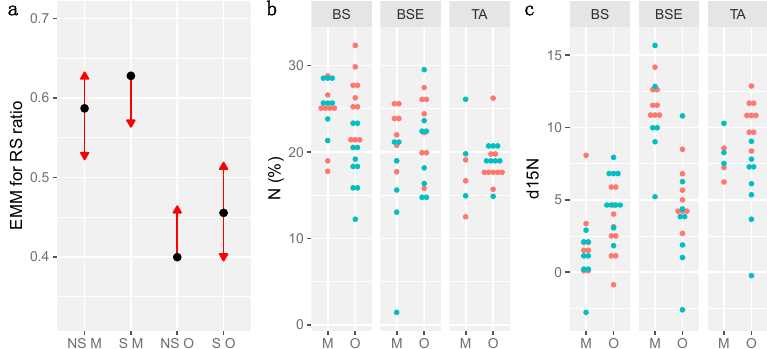
Figure 5. Comparison of estimated marginal means (EMM) showing significant differences of Root/shoot ratio between soil layers and sterilization treatments ( a ), and distribution of percent of N ( b ) and δ 15 N ( c ). BS: Black spruce stand, BSE: BS with Ericaceae, TA: Trembling Aspen stand, NS: non sterile, S: sterile, M: Mineral, O: Organic. In ( a ), blue bars indicate confidence intervals of estimated marginal means, arrows refer to comparisons among marginal means. If two arrows overlap, Tukey post-hoc tests are non-significant and p -value for pairwise comparisons are > 0.05. In ( b ) and ( c ), blue dots refer to sterile treatments, and red dots to non-sterile treatments.